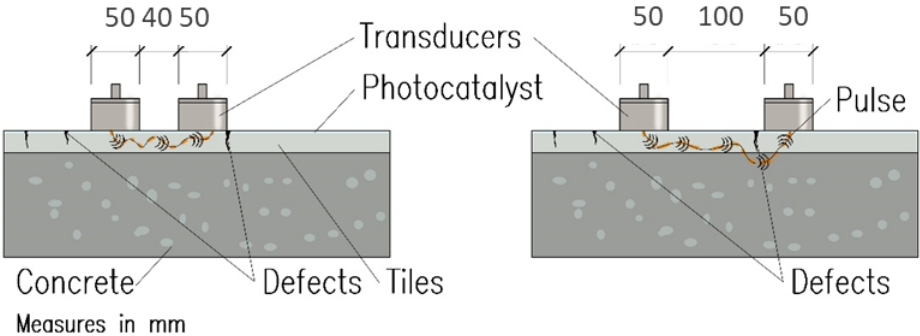
Figure 15. Schema of ultrasonic pulse travel in 15 × 8 cm core specimens and whole slabs with differently spaced transducers.